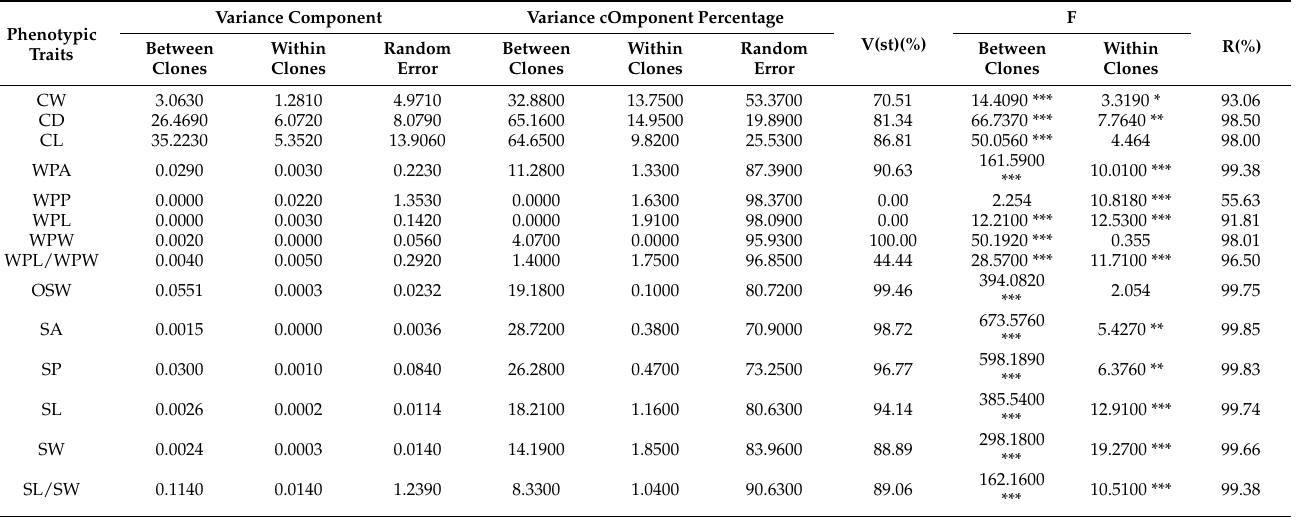
Table 4. Variance component, phenotypic differentiation coefficient, and repeatability of phenotypic characters of cones and seeds of Chinese fir clones in the lower crown